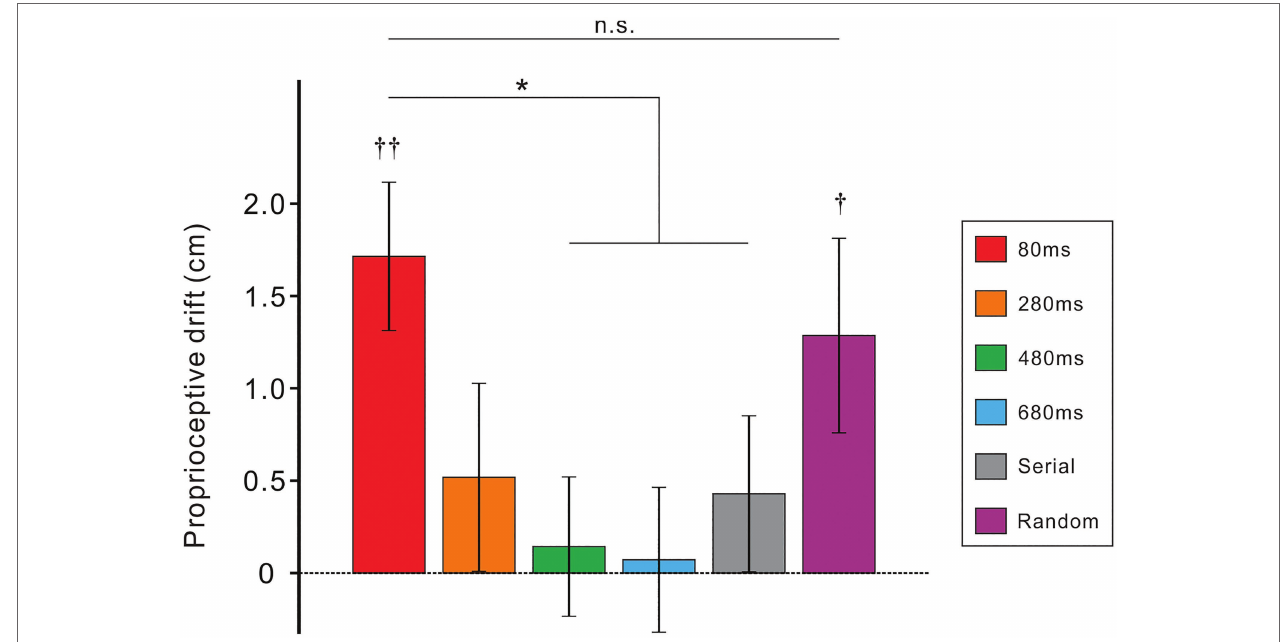
FIGURE 3 | Mean proprioceptive drift (PD) for six experimental conditions with different colors. Vertical lines denote ±1.0 standard error of the mean (SEM). Significance differences from the value of the 80 ms condition (Dunnett test): * ps < 0.05. Significance differences from zero (one-sample t -test): †† p < 0.01, † p <